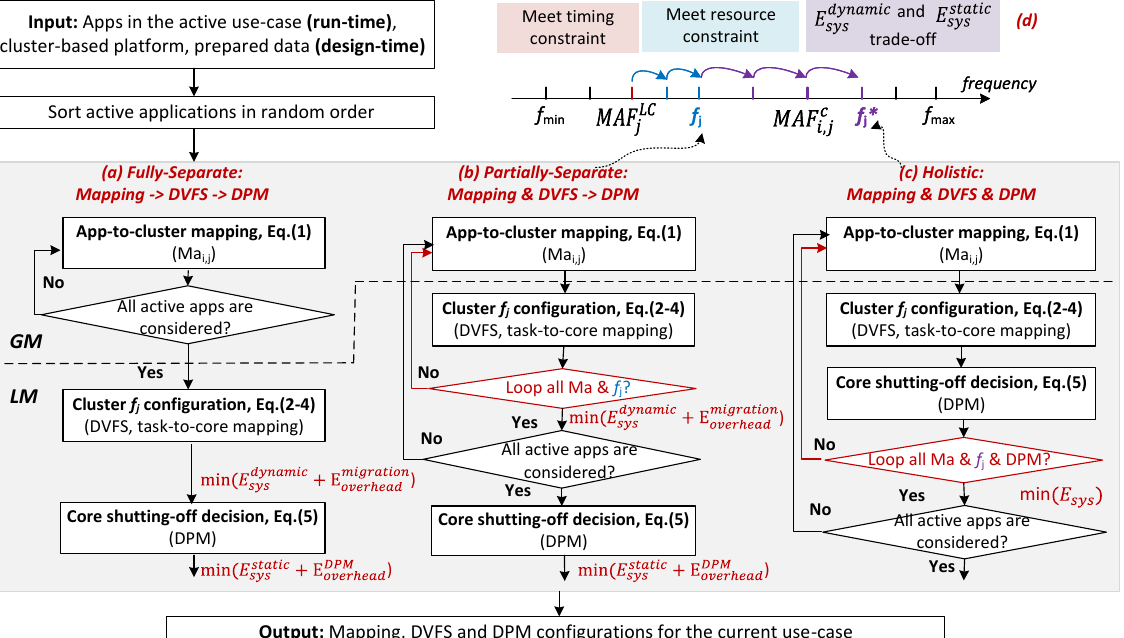
Figure 3. Flowcharts of three management strategies, based on the 0–1 ILP model and HHMS (with GM and LM). ( a ) Fully separate management strategy, ( b ) Partially separate management strategy. ( c ) Holistic management strategy. ( d ) Cluster frequency selection based on